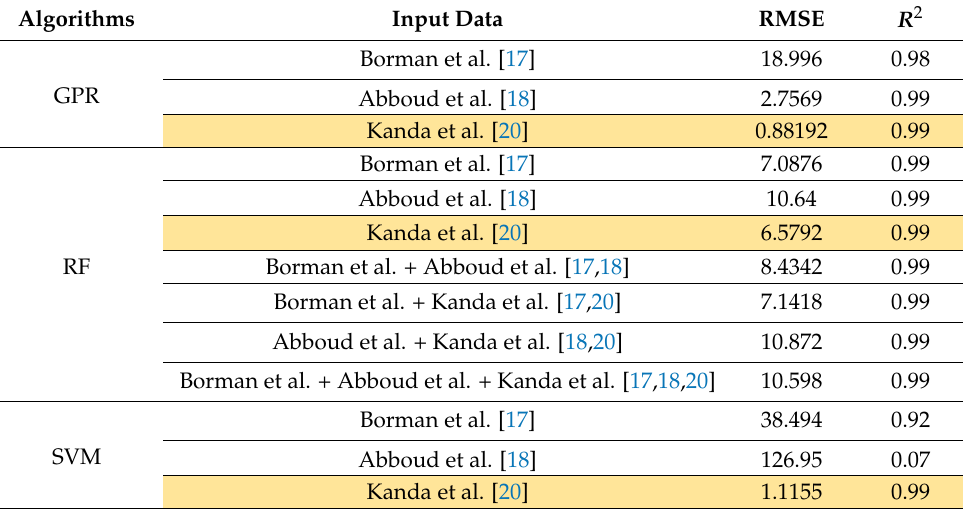
Table A2. Feature Selection by Recursive Feature Elimination for EXP cross-section using Gaussian process regression (GPR), random forest (RF) and support vector machine (SVM). Experimental dataset (EXP) is used as input includes experimental data from Borman et al. [17], Abboud et al. [18] and Kanda et al. [20]. The machine learning model with R 2 closed to 1 and lowest RMSE is highlighted in yellow.